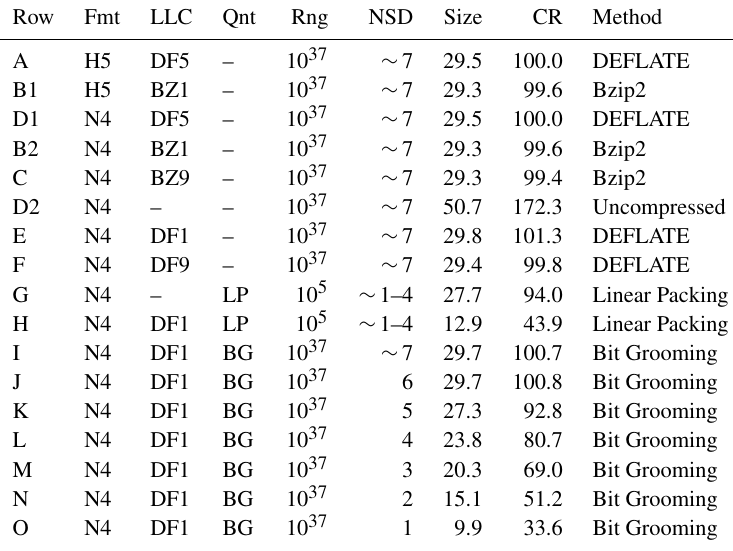
Table 7. Compression ratios for initially compressed HDF5